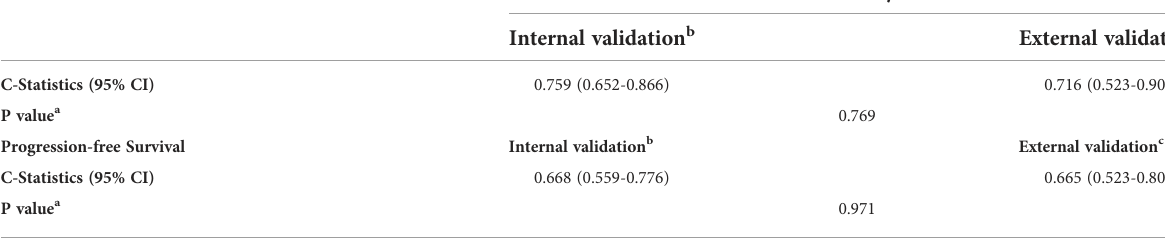
TABLE 6 Validation and performance of the prediction model for overall survival and progression-free survival.